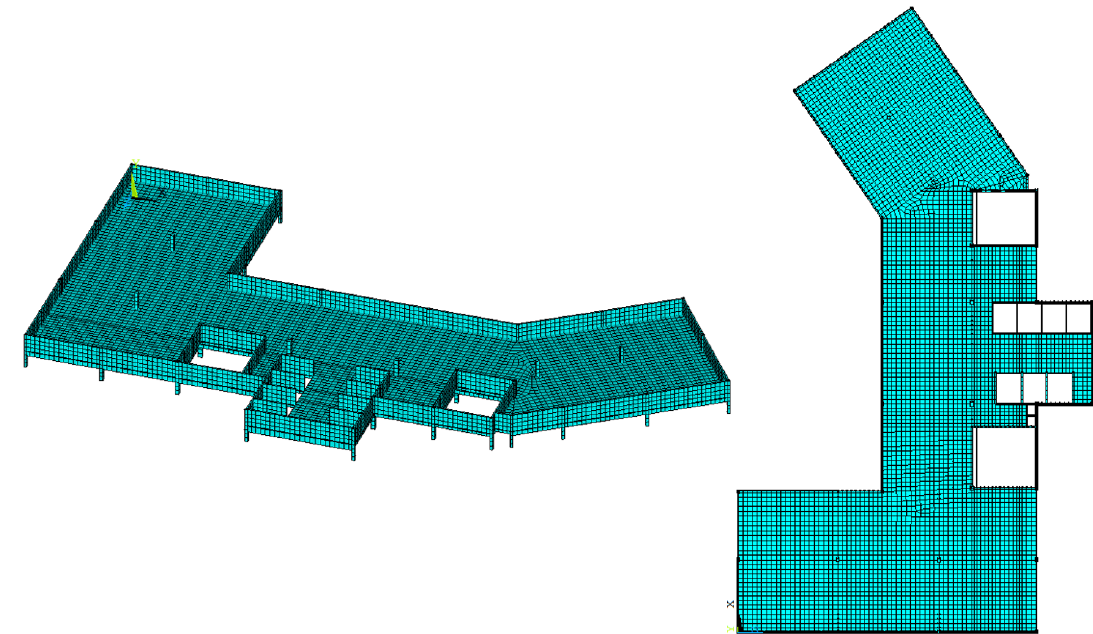
Figure 4. Investigated composite floor (steel-concrete) finite element